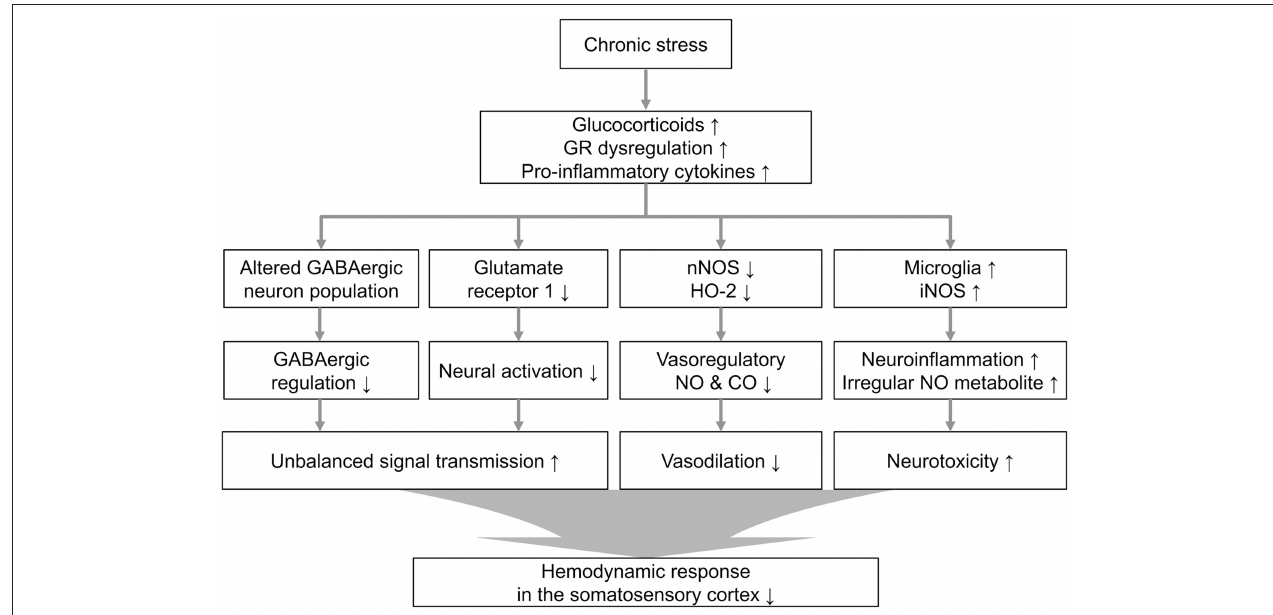
FIGURE 6 | Proposed cellular and molecular signaling pathway alterations associated with chronic stress. Theoretical cascade of the effects of chronic stress, including the neurovasomodulatory alterations suggested by these experimental results from the restraint-stressed rats (GR, glucocorticoid